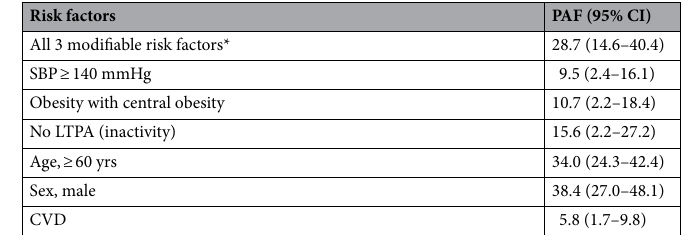
Table 3. The population attributable fractions (PAF) and 95% CI of individual risk factors. CVD, cardiovascular disease; SBP, systolic blood pressure; LTPA, leisure time of physical activity; CI, confidence interval. *The PAF for all 3 risk factors is numerically smaller than the individual sum of PAF estimates as the summative PAF accounts for overlap in the prevalence of risk factors.